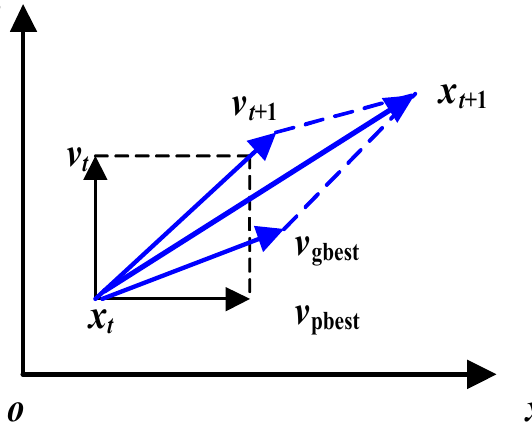
Figure 4. The optimization of